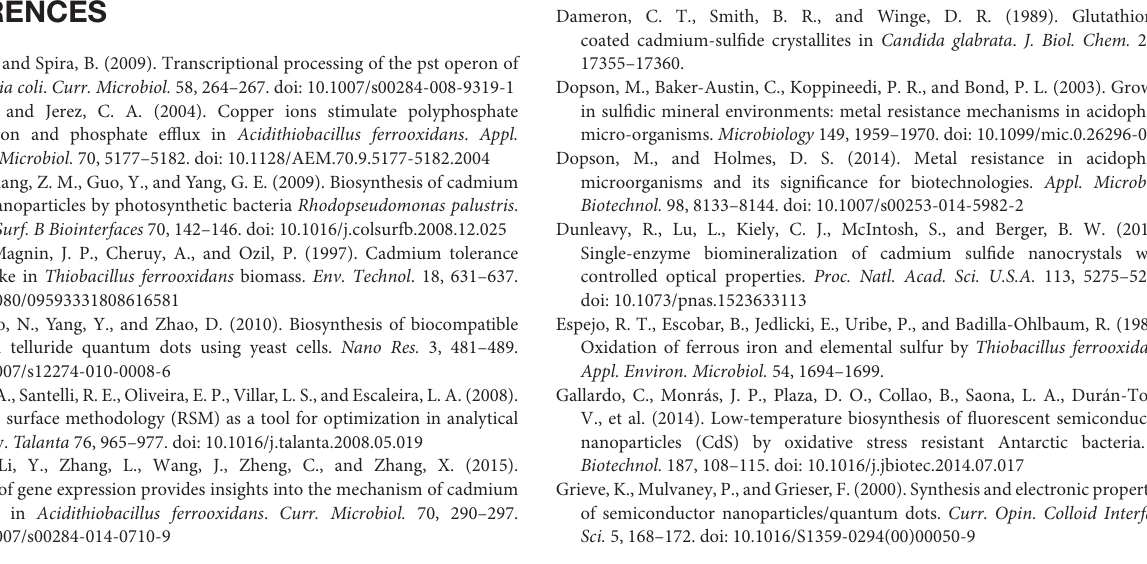
Figure S1 | HR-TEM and EDS analysis of CdS-QDs biosynthesized by A. thiooxidans ATCC 19703 at pH 3.5 in presence of two PO 3 − 4 and Cd 2 + concentrations used to construct the surface response of Figure 1C . QDs biosynthesized by A. thiooxidans ATCC 19703 after exposure to 85mM